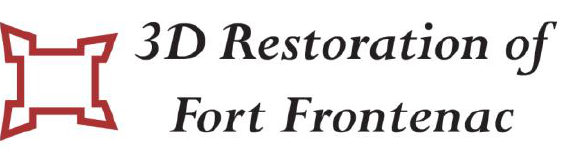
Figure 11: A sample of the representative